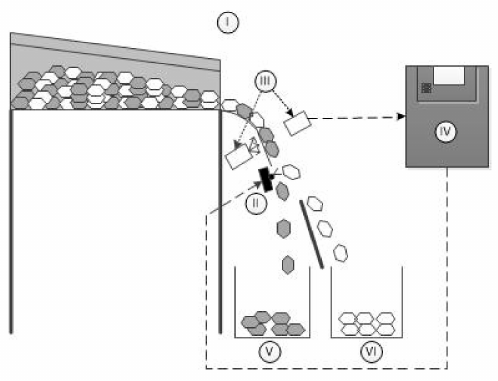
Figure 1. Belt-type sorter: (I) Material presentation by vibrating feeder and belt; (II) sensors; (III) ejection nozzle array; (IV) central processing unit (CPU); (V) drop fraction; and (VI) ejected fraction.